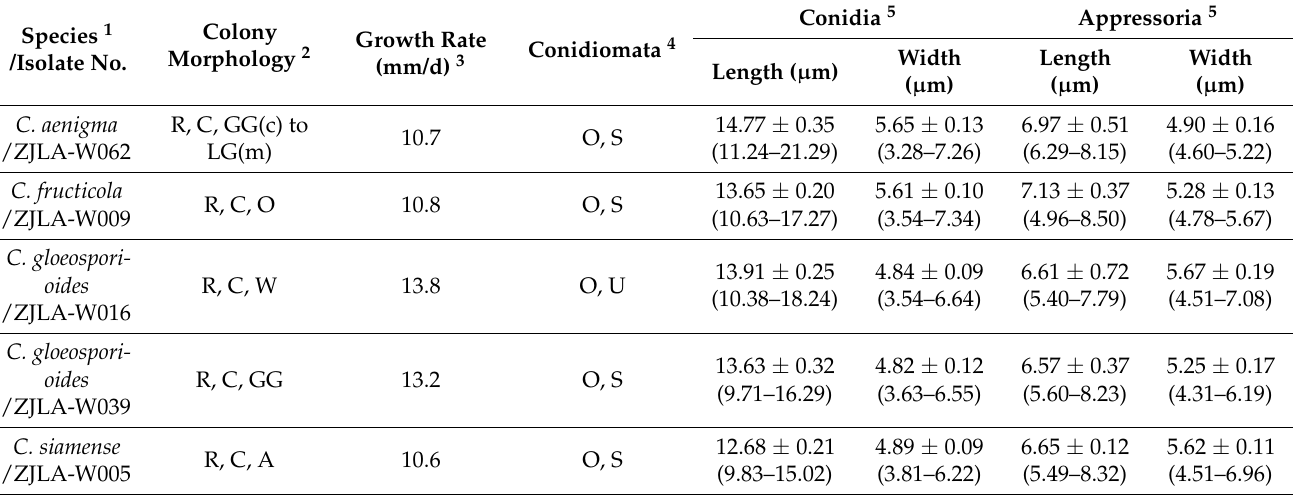
Table 2. Morphological data of Colletotrichum isolates on PDA medium.